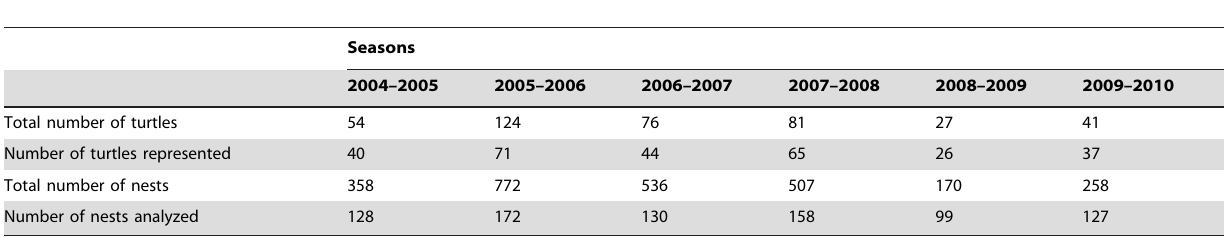
Table 1. Number of female turtles and nests registered per season and included in the analyses.